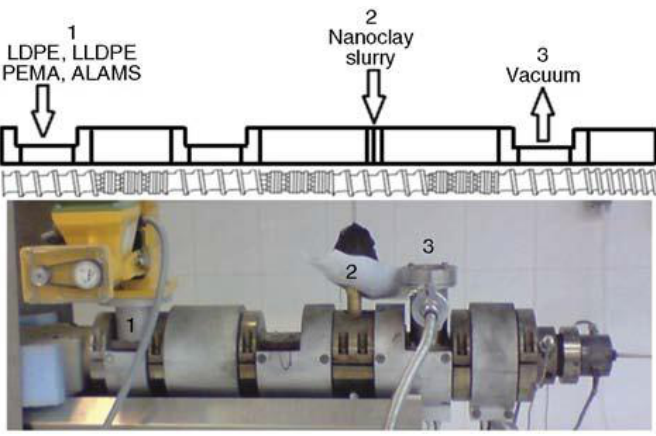
Figure 5. Schematic configuration of the screw and the order of mixing of the materials ( top ) and the actual twin-screw extruder during sample preparation process ( bottom ) [30,33] (with permission of BME-PT)